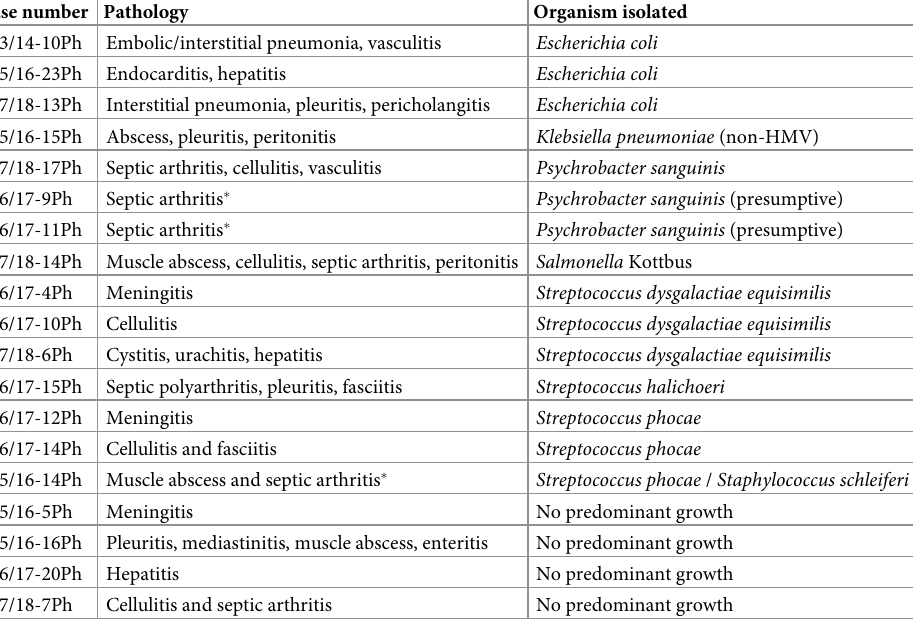
Table 5. Summary of infections other than HMV K . pneumoniae , that were the cause of death in New Zealand sea lion ( Phocarctos hookeri ) pups at Sandy Bay, Enderby Island between 2013 and 2018. Case number